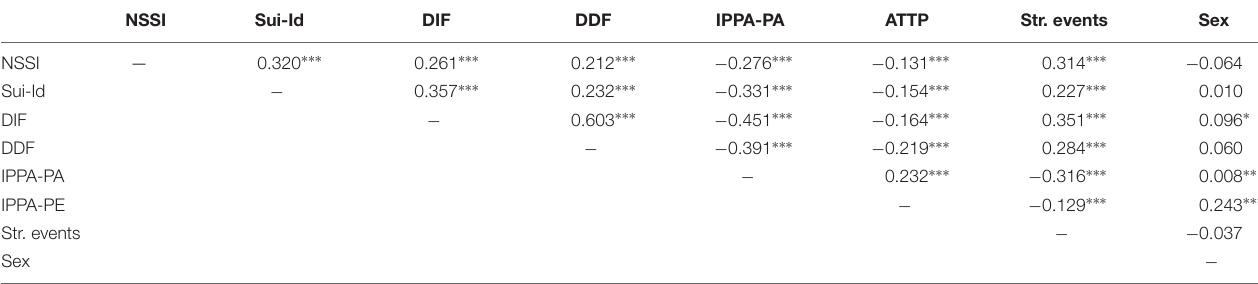
TABLE 2 | Correlation